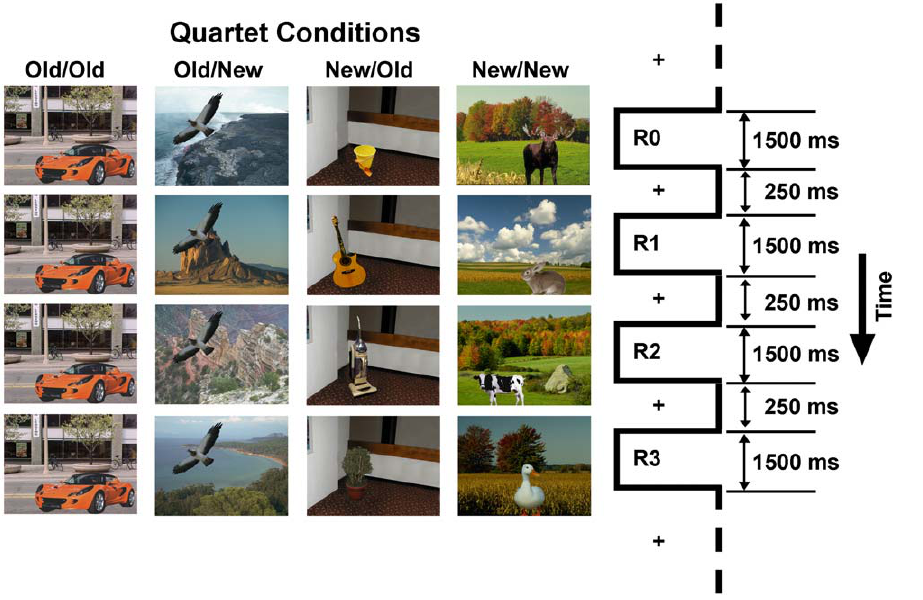
Figure 1. Schematic of the experimental design showing example stimuli from the four picture quartet conditions (left) and the display timings (right).